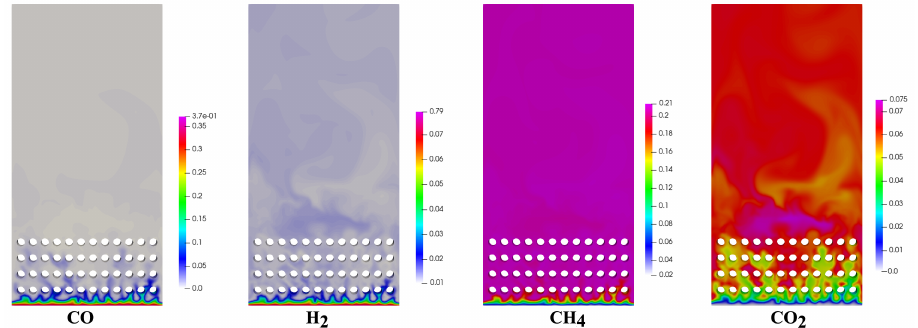
Figure 2. Snapshot of instantaneous mass fraction of gas species. Nitrogen is utilized as balance